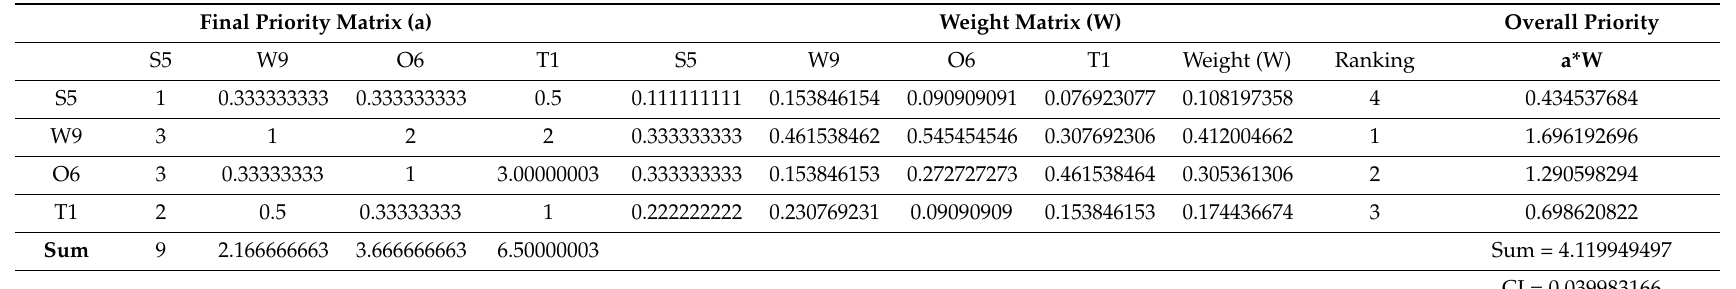
Table 7. Priority calculations for Final SWOT